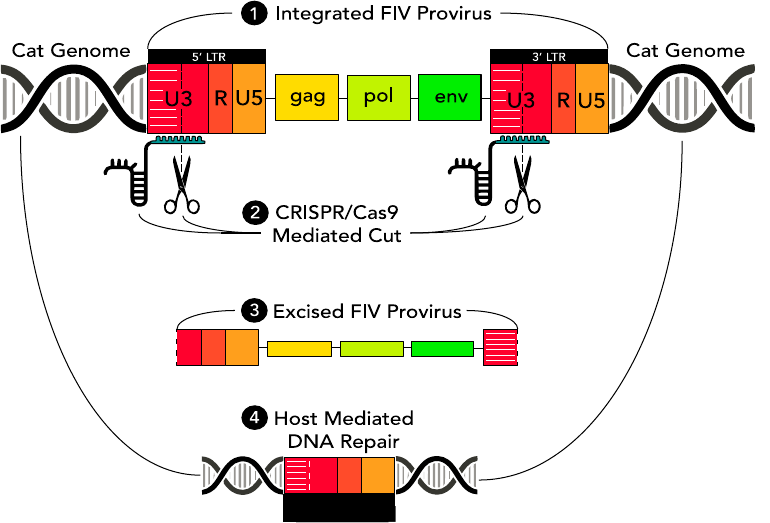
Figure 1. Clustered regularly interspersed short palindromic repeats (CRISPR)-associated protein 9 (Cas9) gene editing